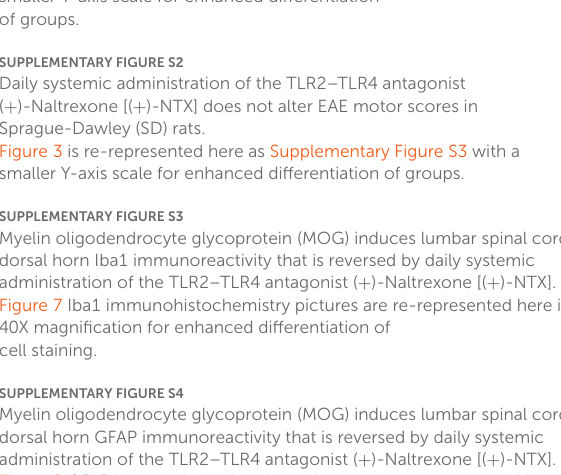
Figure 1 is re-represented here as Supplementary Figure S2 with a smaller Y-axis scale for enhanced differentiation of